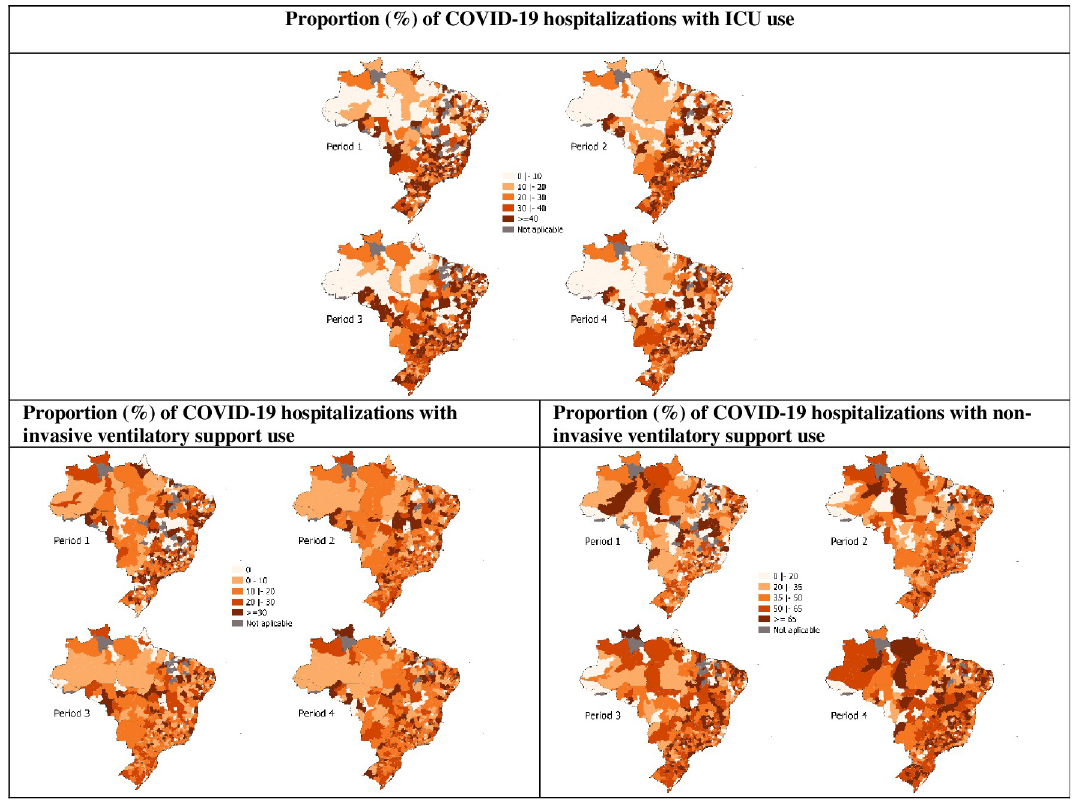
Fig 3. Spatiotemporal distribution of ICU, invasive, and non-invasive ventilatory support use among COVID-19 hospitalizations. Brazil, epidemiological weeks 09/2020–11/2021, 23 Feb 2020–20 Mar 2021. Sources: SIVEP-Gripe, Minister of